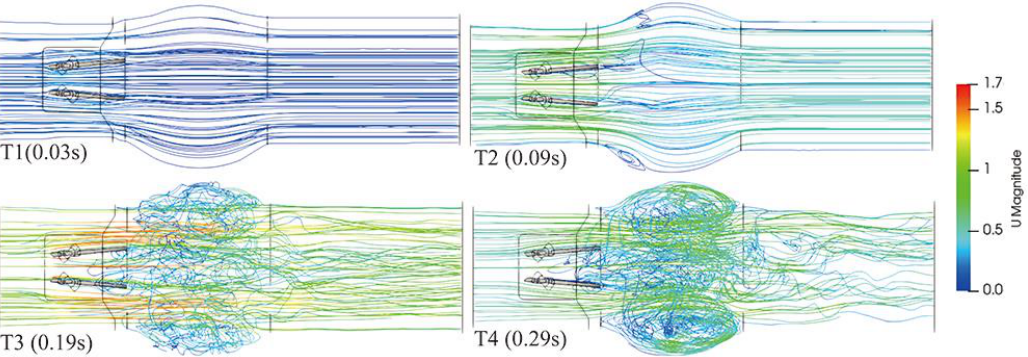
Figure 12. 3D-velocity streamlines of a simulation flow in the MHV (Newtonian model). The velocity streamlines flowing through the hinge regions are shown in Figure 13.